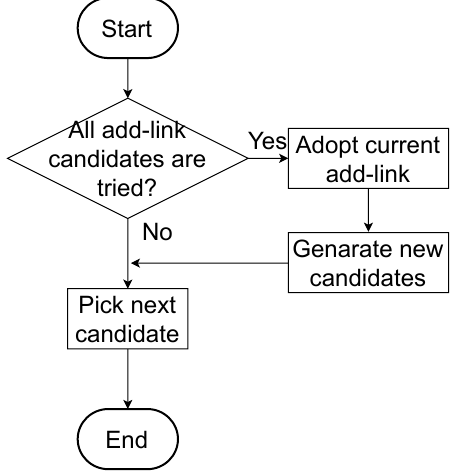
Figure 11. Flowchart of Add-link